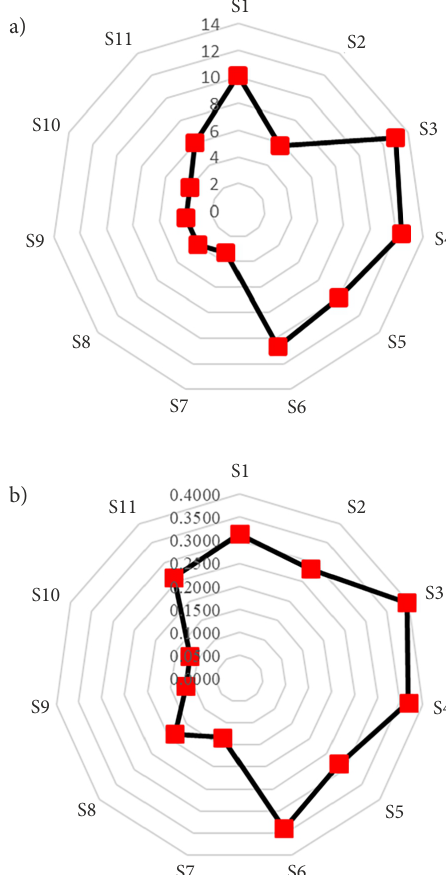
Figure 3. Analysis of the risks ranking with regard to final weights obtained from: (a) traditional risk matrix approach, (b) RAM